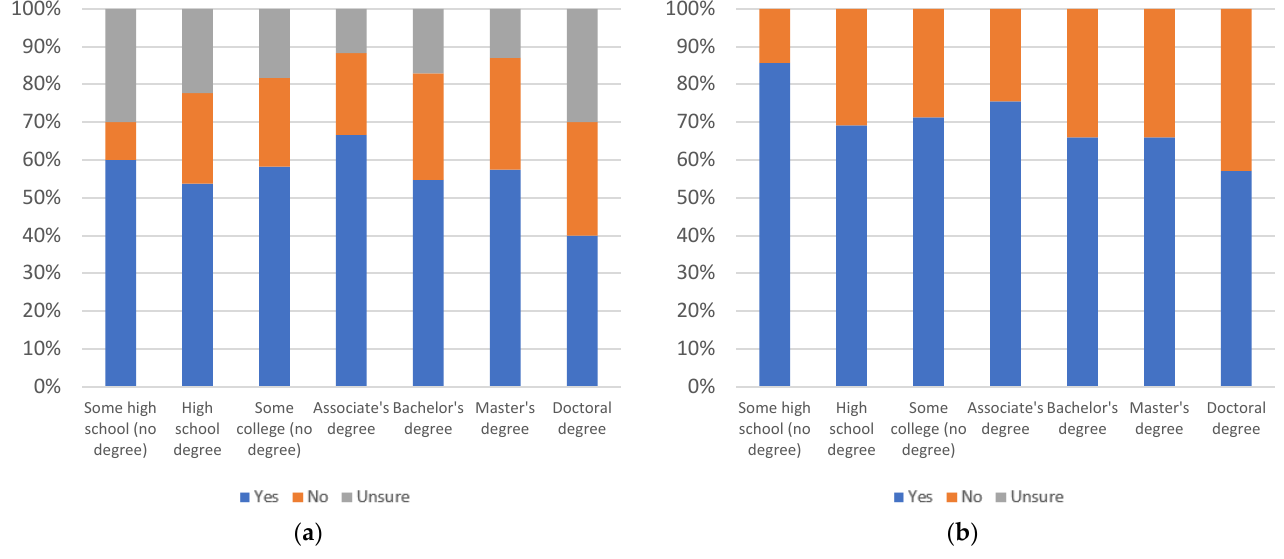
Figure 82. Label trustworthiness judging use, by education level: ( a ) with uncertain respondents (left) and ( b ) without uncertain respondents (right).